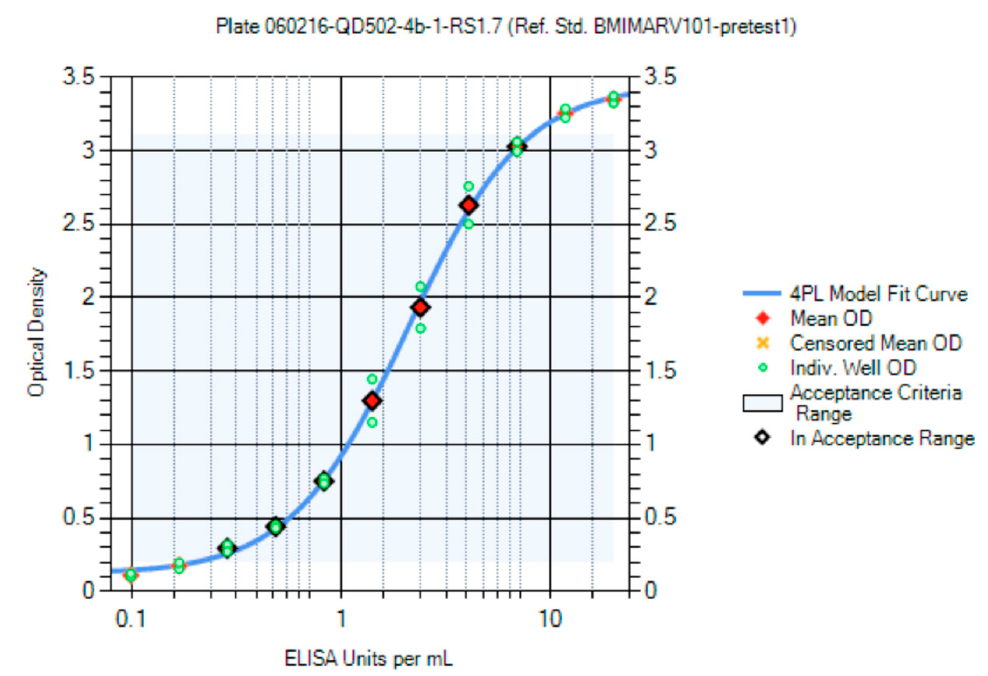
Figure 7. Optimization of BMIMARV101 Reference Standard Dilution Scheme. BMIMARV101 was tested at a 1:100 starting dilution (Initial 1:2 dilution with naïve serum followed by a 1:50 dilution on the plate) and 1:1.7 dilution scheme.